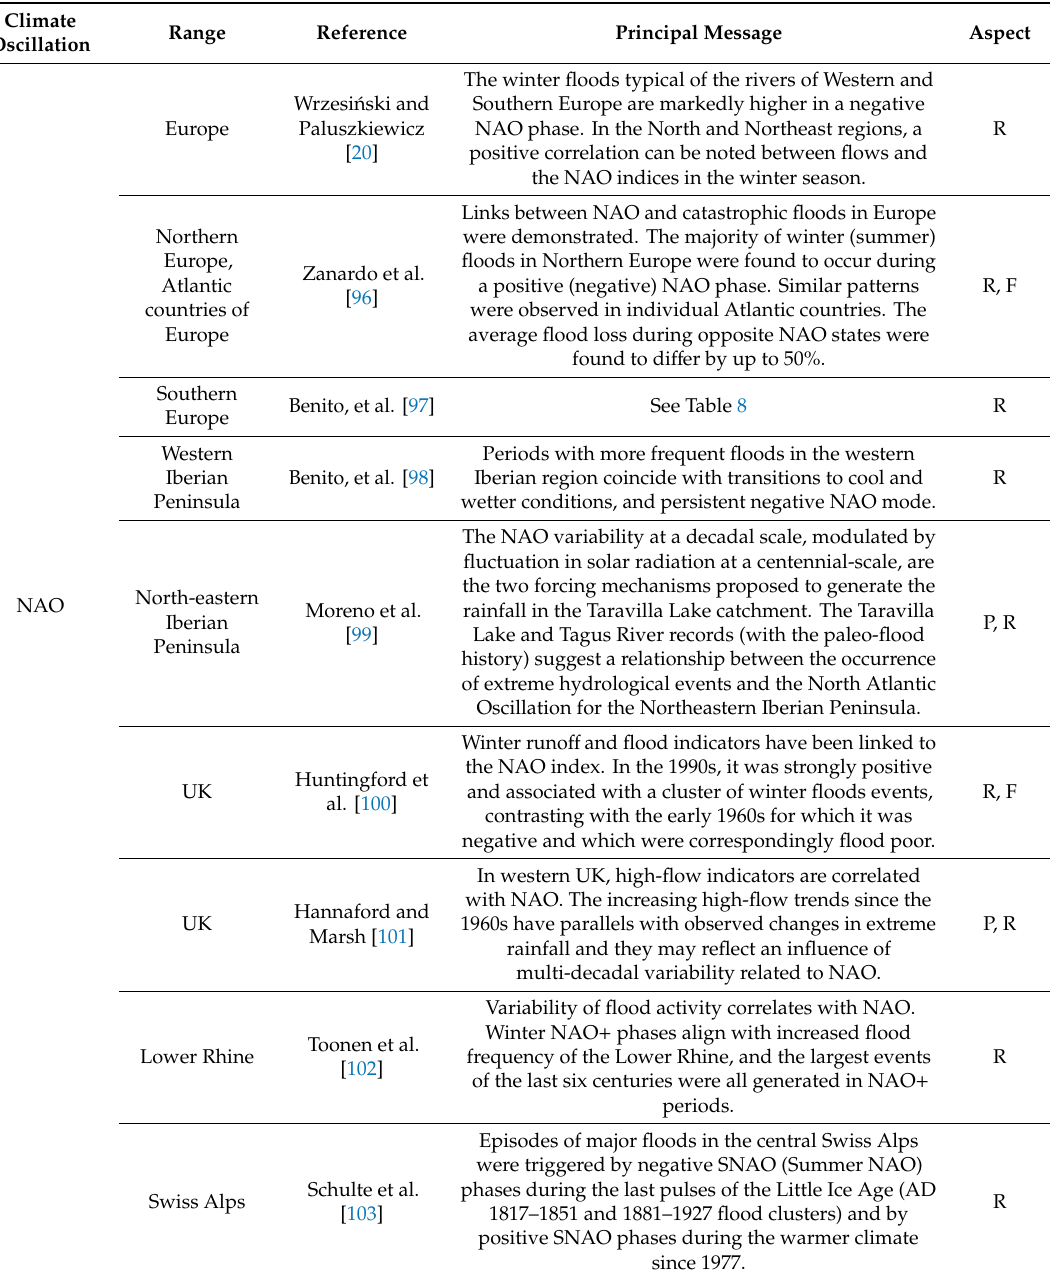
Table 7. Review of links between climate oscillation and floods for Europe, as reported in the literature. Aspects of reference in the rightmost column—as in Table